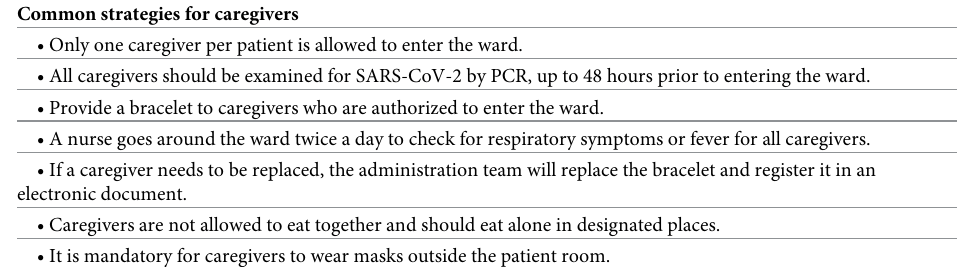
Table 3. Strategy for caregivers to prevent COVID-19 transmission. Common strategies for